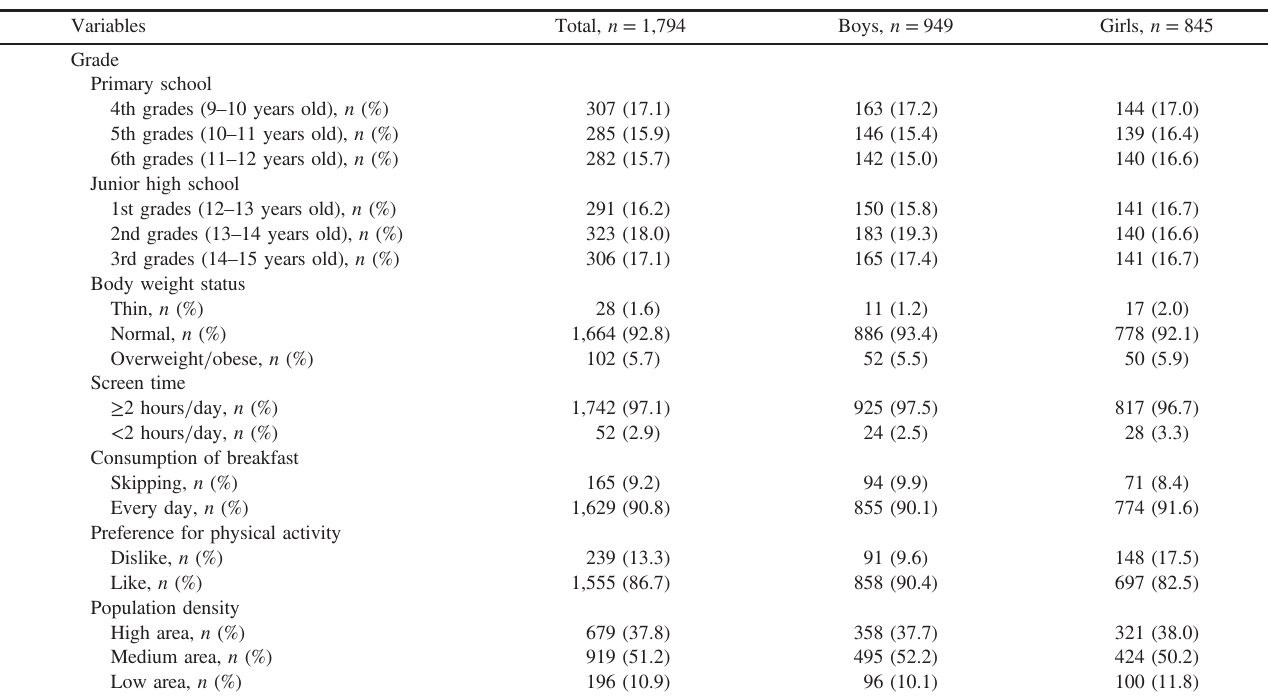
Table 1. Participants ’ characteristics